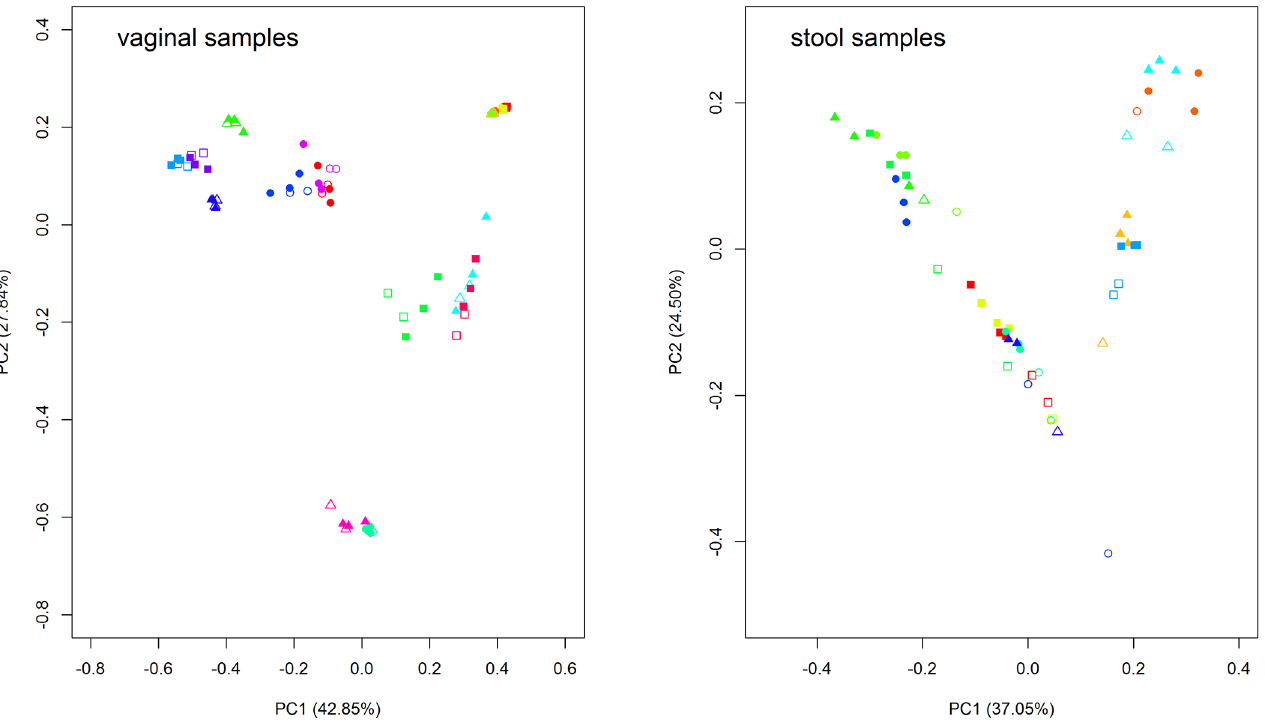
Fig 2. Principal coordinates analysis (PCoA) of weighted UniFrac distance. Proportion of variance explained by each axis is denoted in the corresponding axis labels. Each symbol (designated by the combination of color and shape) represents each subject with the open symbols for the nested PCRs and the closed symbols for the standard PCRs. For example, the blue circles represent subject 1 with open blue ones for two nested PCR results and closed blue ones for three standard PCR